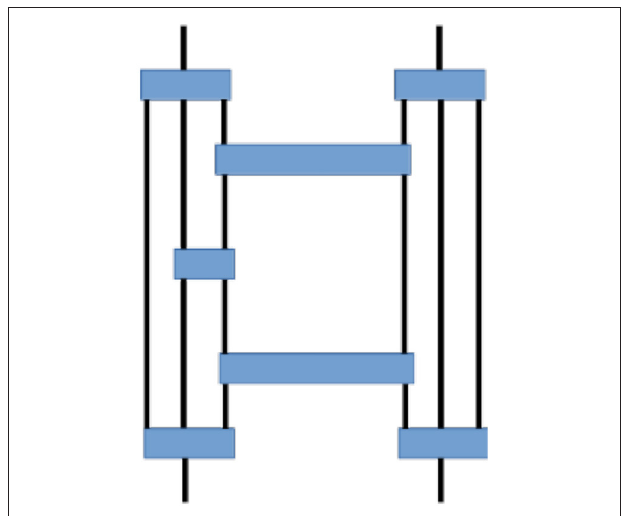
FIGURE 3 | Graphical diagram depicting a fragment of the 3:1 MERA tensor